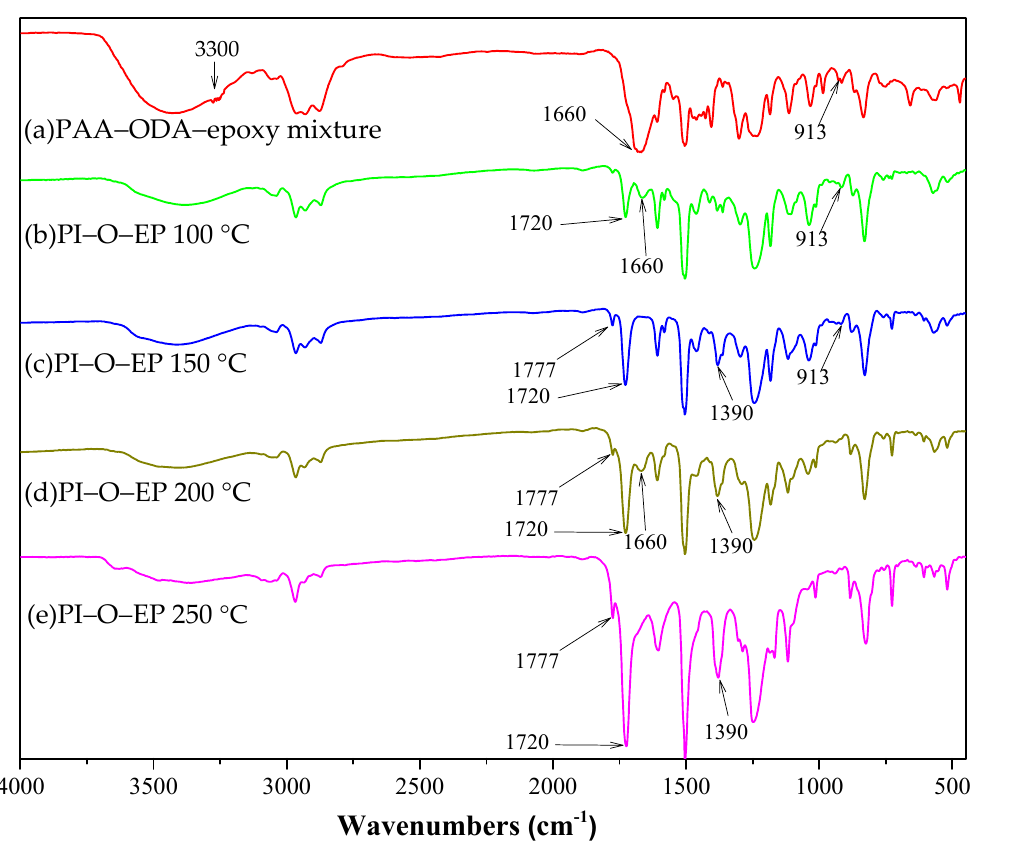
molecules still remain unreacted (at 100 °C).